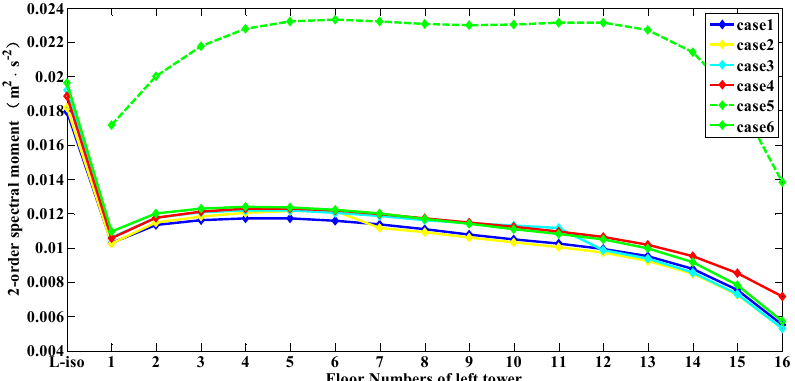
Figure 12. Second-order spectral moment of the displacement of each layer of the left tower.